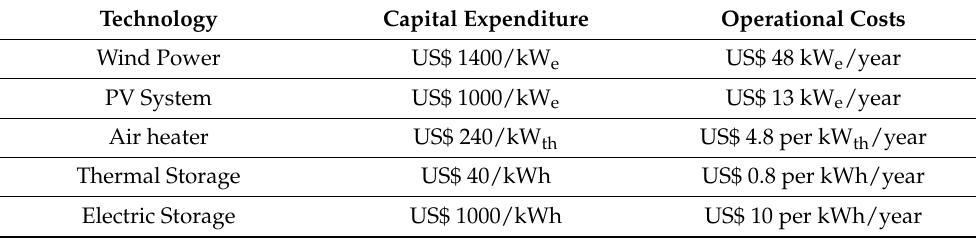
Table 5. The assumed values of capital and operating expenditure used in the economic